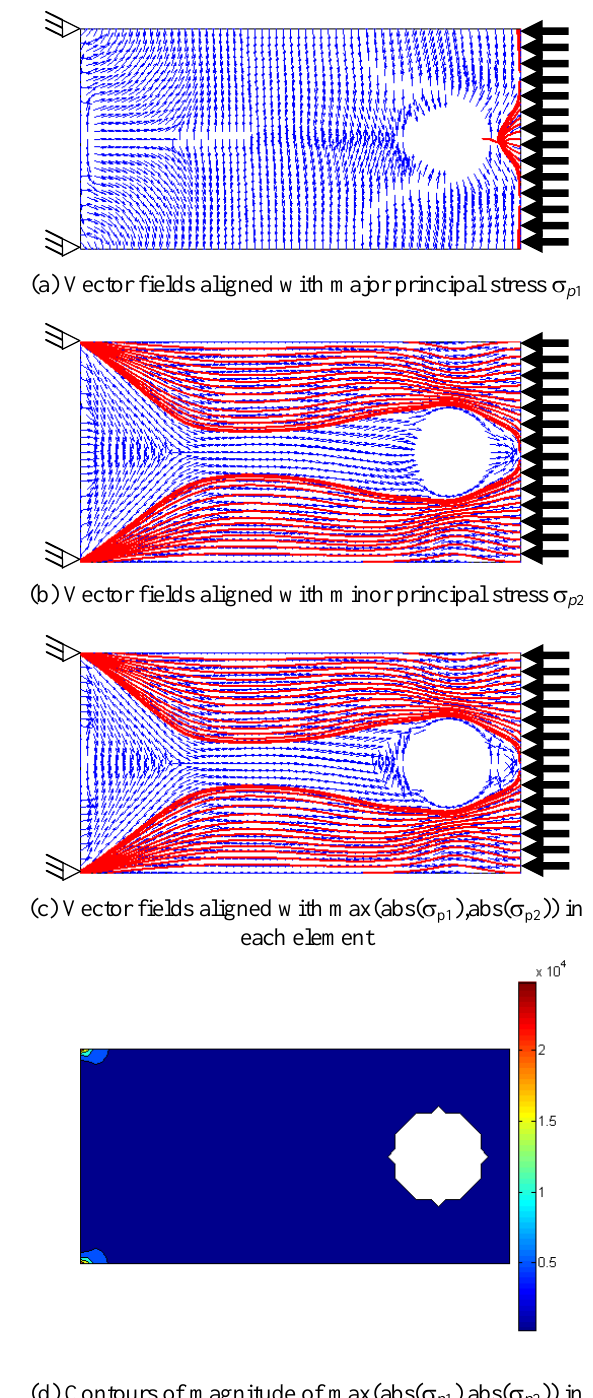
Fig. 25. Load paths based on principal stresses with a hole and distributed loading in the structure Again, the load flow with equilibrium in x -direction is e counterpart of minor principal stress (Figure 26 (a)). The th atterns are more complex for load flow with equilibrium in p direction (Figure 26 (b)). There are many regions with y - e y -direction circulatory patterns in th load flow, especially near the hole. The circulatory patterns are self equilibrating bec ause the y -components of the loads are zero.